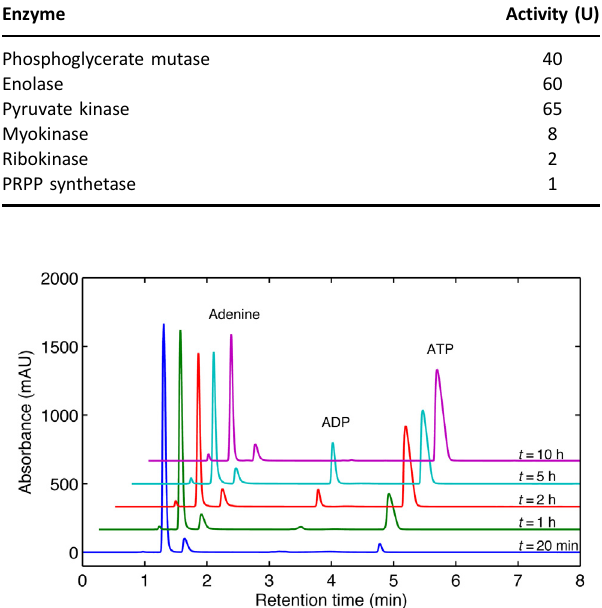
Figure 11. HPLC chromatograms of the reaction mixture used for the synthesis of [4 ′ - 2 H]ATP, after 0, 1, 2, 5, and 10 h. Chromatograms are shifted by a fi xed percentage in time and absorbance for visual clarity.